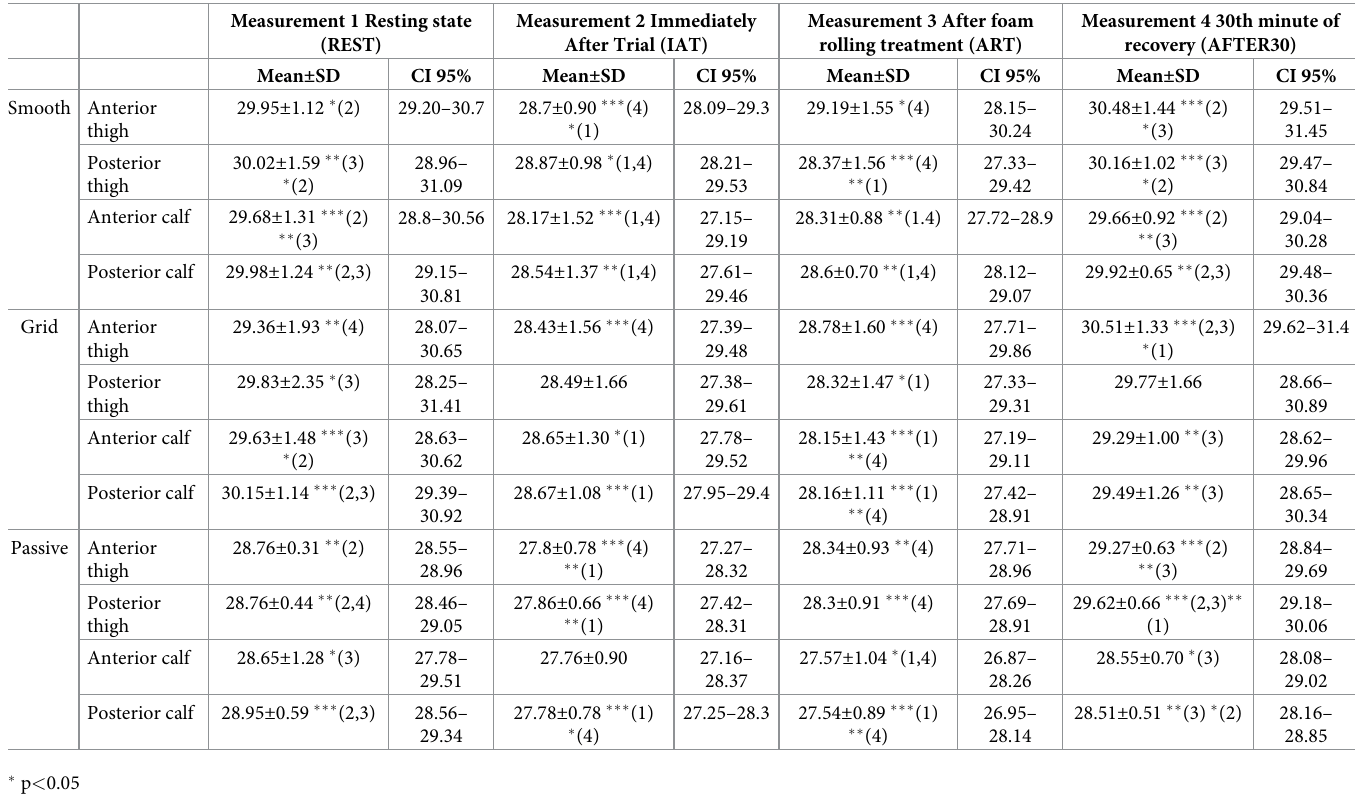
Table 2. Mean values [˚C] of the anterior and posterior skin surface temperature of ROIs in consecutive measurements. Measurement 1 Resting state